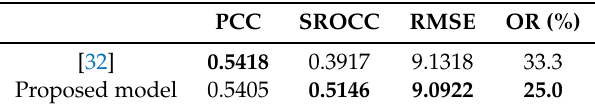
Prediction performance of reference model and the proposed model over subjective